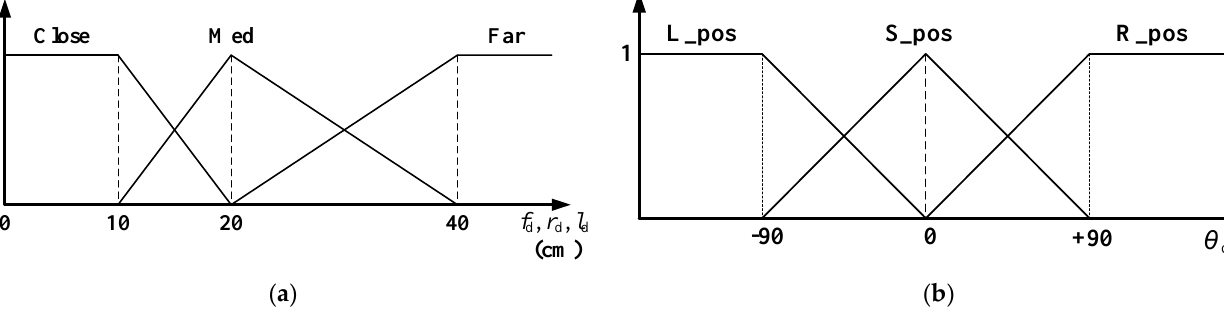
tance data; ( b ) membership function for the fuzzification of positioning data. data; ( b ) membership function for the fuzzification of positioning